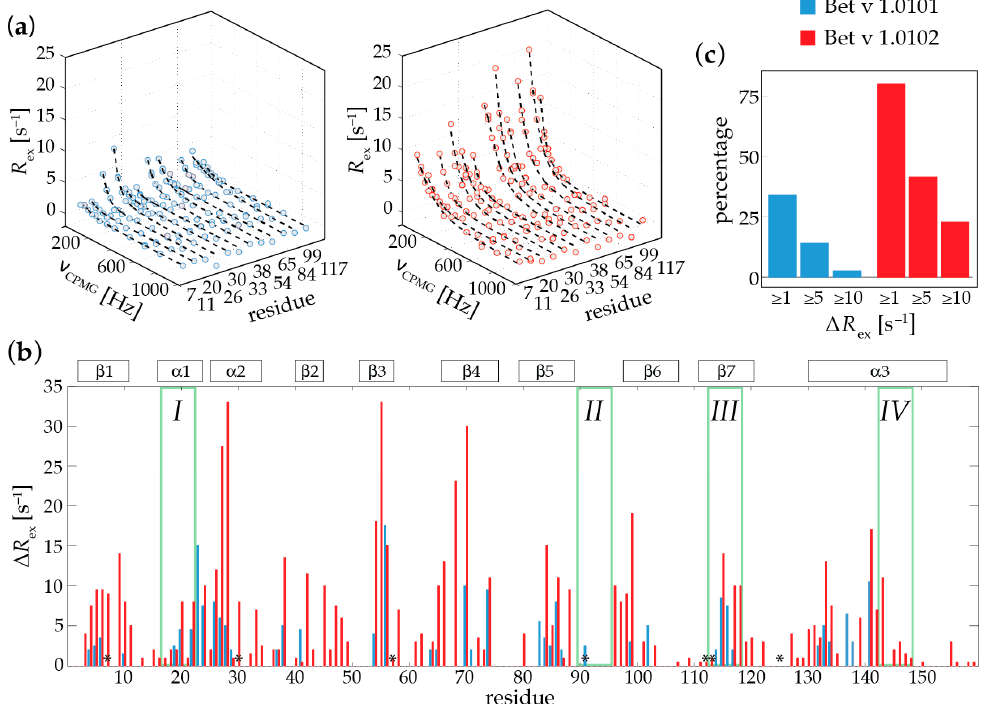
Figure 1. Experimental NMR microsecond-millisecond conformational flexibility in Bet v 1 isoforms. ( a ) Backbone amide 15 N relaxation dispersion profiles for Bet v 1.0101 ( blue , left ) and Bet v 1.0102 ( red , right ), recorded at 800 MHz, 298 K, pH 8.0. Experimental data (circles) are shown for a subset of 12 representative amino acid residues in both isoforms (Thr7 (Ile7 in Bet v 1.0102), Ser11, Lys20, Gly26, Phe30 (Val30 in Bet v 1.0102), Val33, Ile38, Lys54, Lys65, Ser84, Ser99, Ser117), along with best-fit curves (dashed lines). Microsecond-millisecond time scale transitions between different conformers are manifest as non-flat relaxation dispersion profiles ( R ex > 0); ( b ) Site-resolved amplitudes, ∆ R ex = R ex ( ν CPMG = 1000) − R ex ( ν CPMG = 0), of the relaxation dispersion profiles for Bet v 1.0101 ( blue ) and Bet v 1.0102 ( red ). Amino acid positions that are different in Bet v 1.0101 and Bet v 1.0102 are indicated by asterisks (*), and early proteolytic cleavage sites I – IV according to Freier [13] are shown in green. Secondary structure elements ( α 1– α 3 and β 1– β 7) are shown as defined by Gajhede et al. [17]; ( c ) Proportions of backbone amides for which ∆ R ex values in Bet v 1.0101 ( blue ) and Bet v 1.0102 ( red ) are equal to or greater than 1, 5 and 10 s − 1 , respectively.